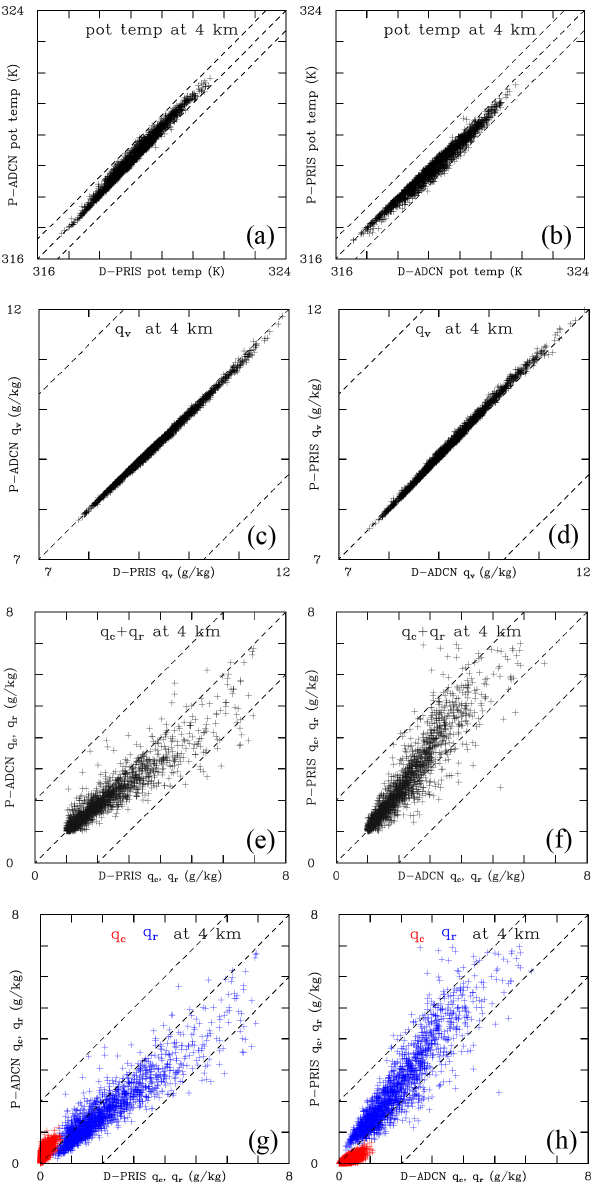
Figure 13. Driver versus piggybacker for components of the buoy- ancy at 4km shown in the lower panels of Fig. 12. (a, b) Tempera- ture, (c, d) water vapor, (e, f) total loading, and (g, h) loading split into cloud water (red) and rain (blue). Dashed lines below and above the 1 : 1 dashed line in all panels correspond to the buoyancy impact as shown by dashed lines in Fig. 12. Only 5% of data points with the vertical velocity larger than 1ms − 1 and the total condensate larger than 1gkg − 1 are used.